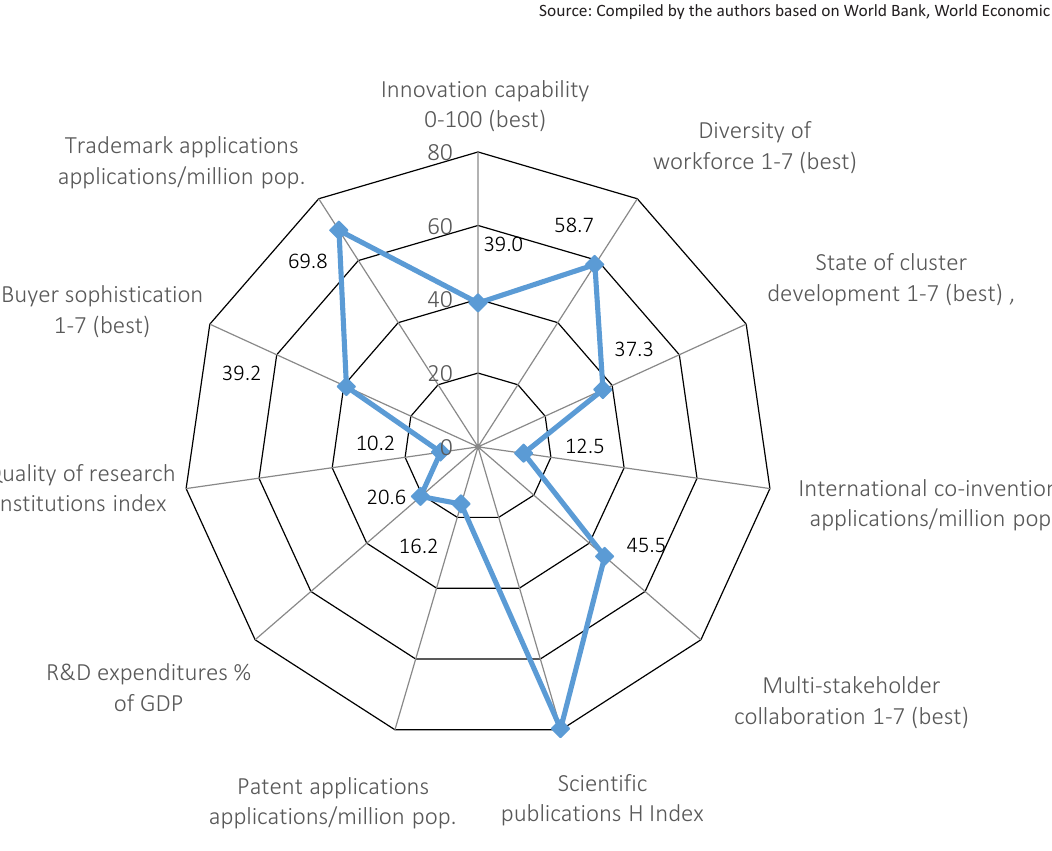
Figure 2. “Innovation capability” element estimation of Global Competitiveness Index of Ukraine in